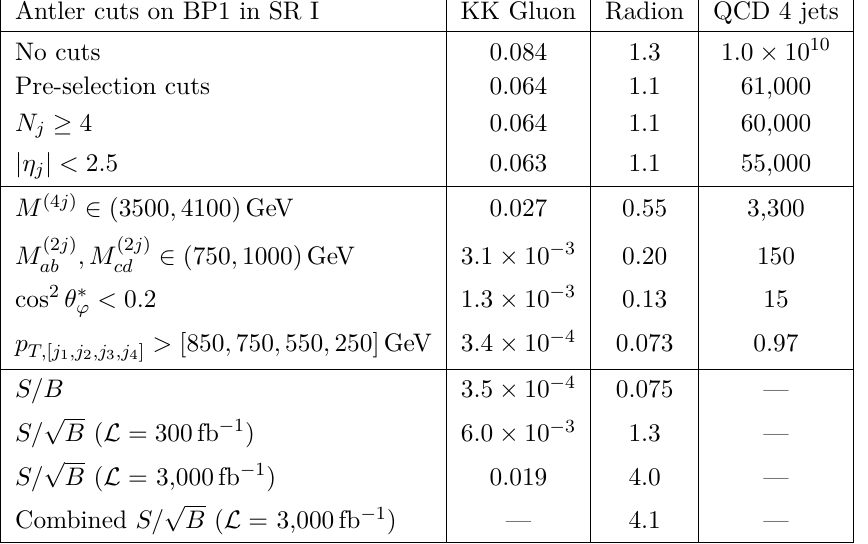
— = 3 . 25 , (cid:15) = 0 . 75 , m ( G ) = 4 TeV , m ( g ) = KK KK KK > T, [ j 1 ,j 2 ,j 3 ,j 4 ]